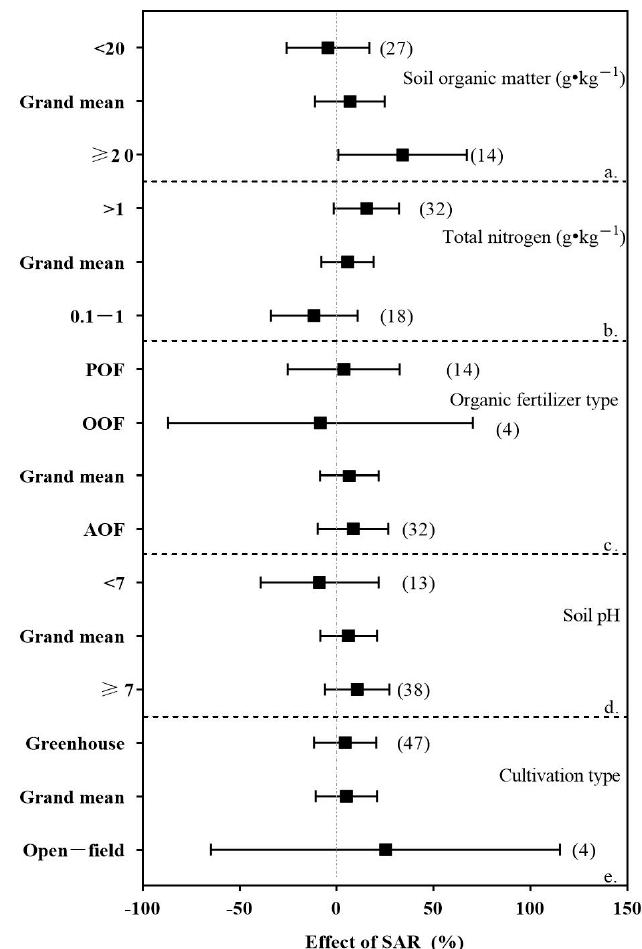
Figure 7. Organic fertilizers combined with soil organic matter ( a ), total soil nitrogen ( b ), type of organic fertilizers ( c ), soil pH ( d ), and cultivation type ( e ) on tomato SAR (sugar/acid content ratio) percentage changes. Points represent the mean effect, while bars represent 95% confidence intervals. The numbers on the right side of the confidence intervals represent the sample sizes. AOF, animal organic fertilizer; MOF, mixed animal-and-plant organic fertilizer; POF, plant organic fertilizer; OOF, other organic fertilizer.